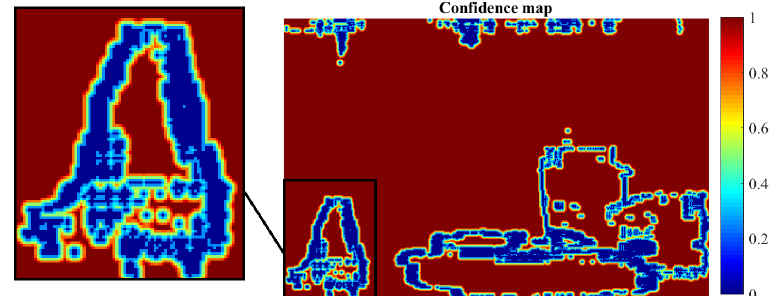
Figure 6. Artificial “Futuristic White-Tower” sequence: estimation confidence